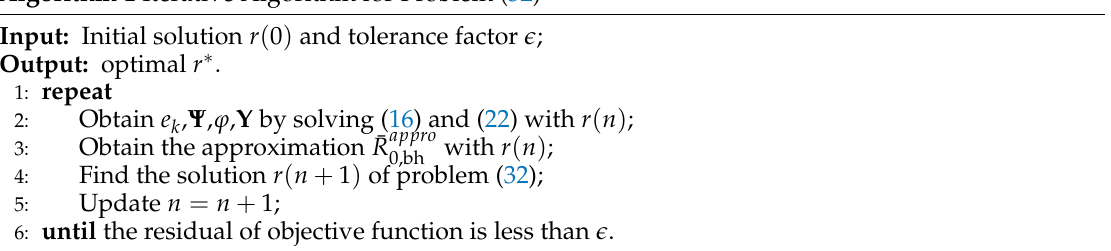
Algorithm 1 Iterative Algorithm for Problem